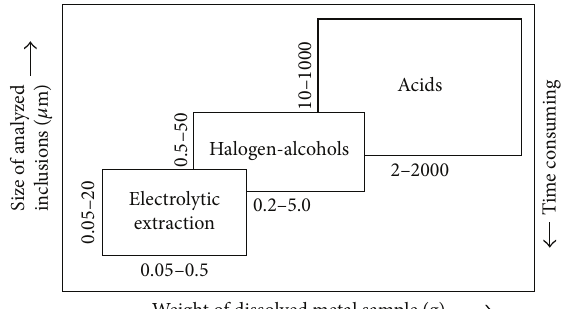
Figure 1: Application of different extraction methods for investiga- tion of nonmetallic inclusions in metal sample.